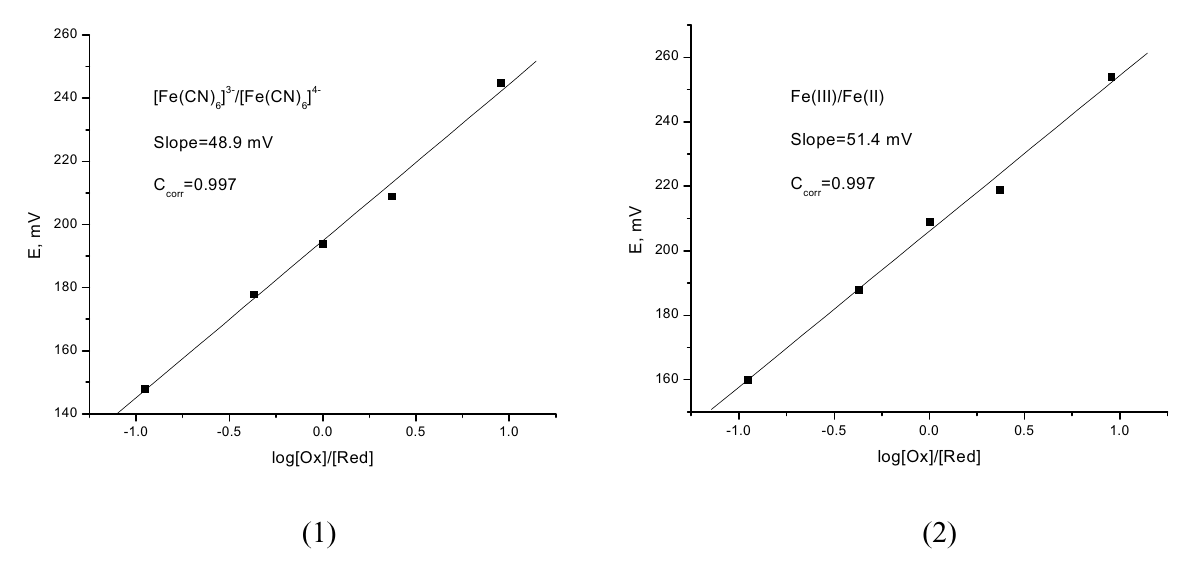
Figure 2. Plots of E against log (c